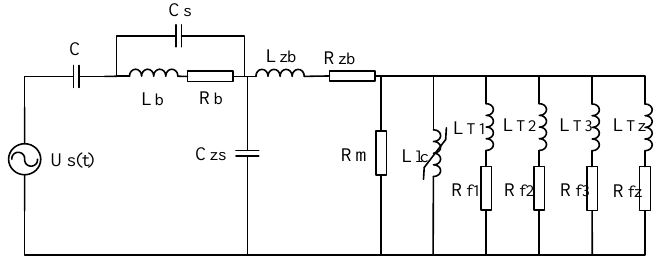
Figure 1. Equivalent schematic diagram of CVT.